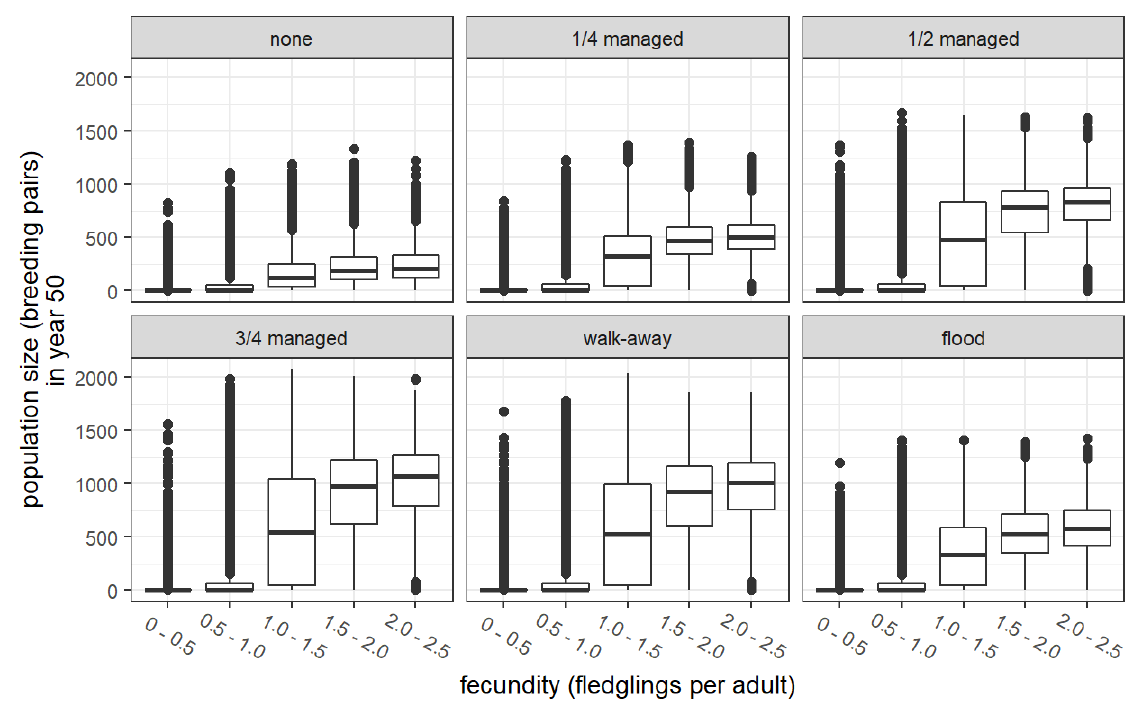
Figure A2.2. Number of breeding pairs in final year of simulation. Results are summarized under the full range of parameter uncertainty for six potential habitat management scenarios. Results are grouped by fecundity ranges achieved after simulated impact from Brown-headed Cowbird brood